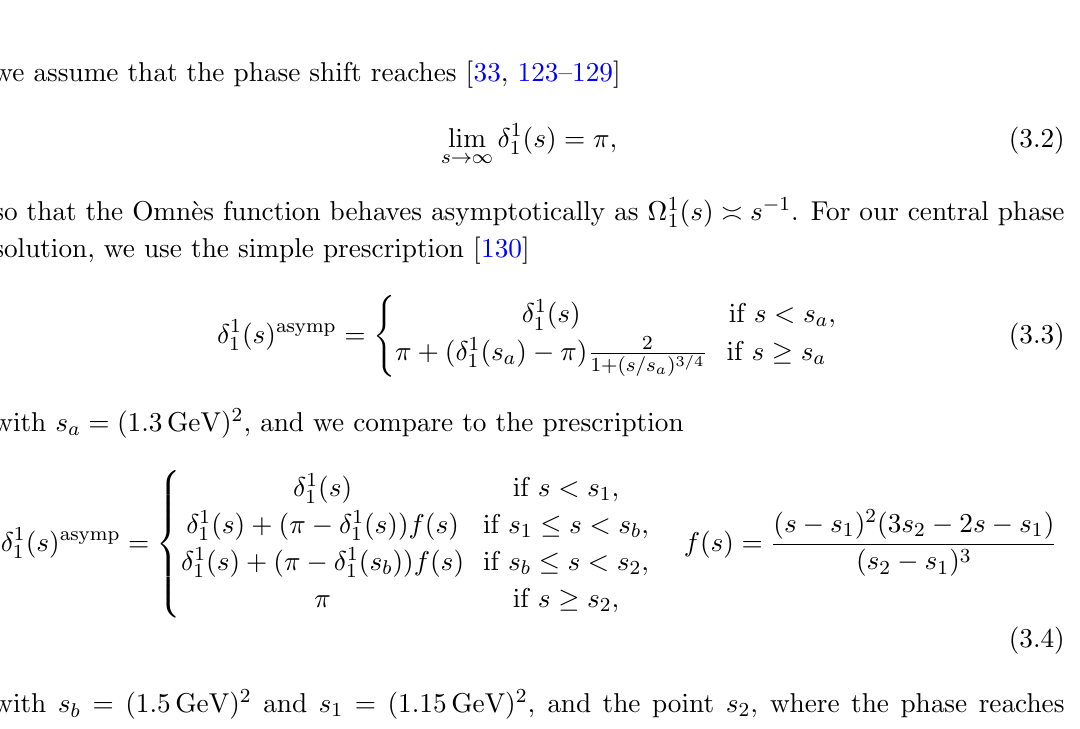
Figure 3. Elastic P -wave (cid:25)(cid:25) scattering phase shift (cid:14) 1 We show the central phase solution with an uncertainty band generated by varying all parameters apart from the phase values at s 0 and s 1